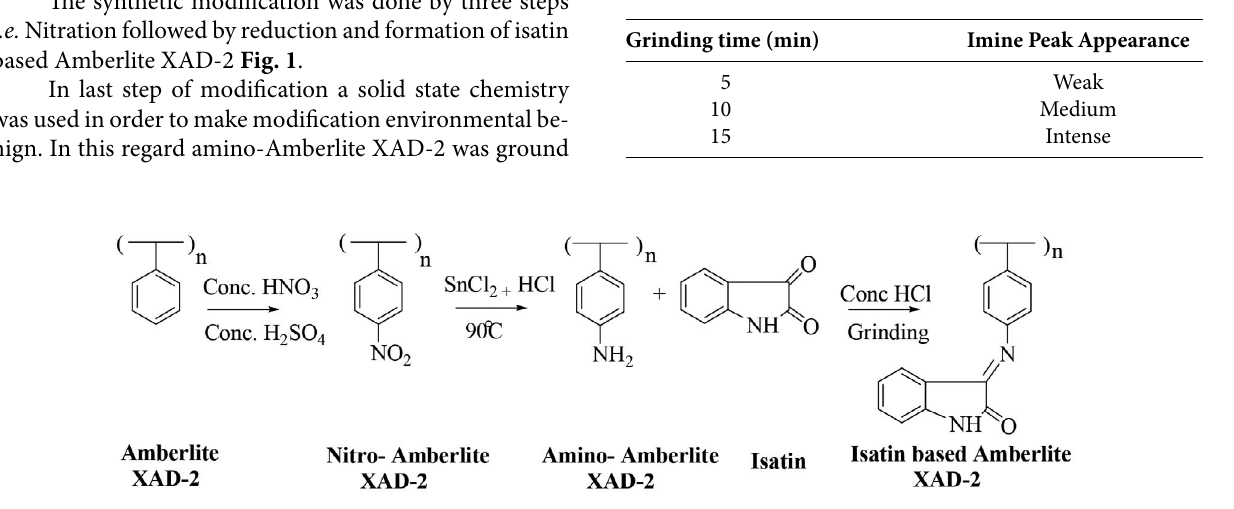
Table 1. Grinding Time for Maximum Conversion